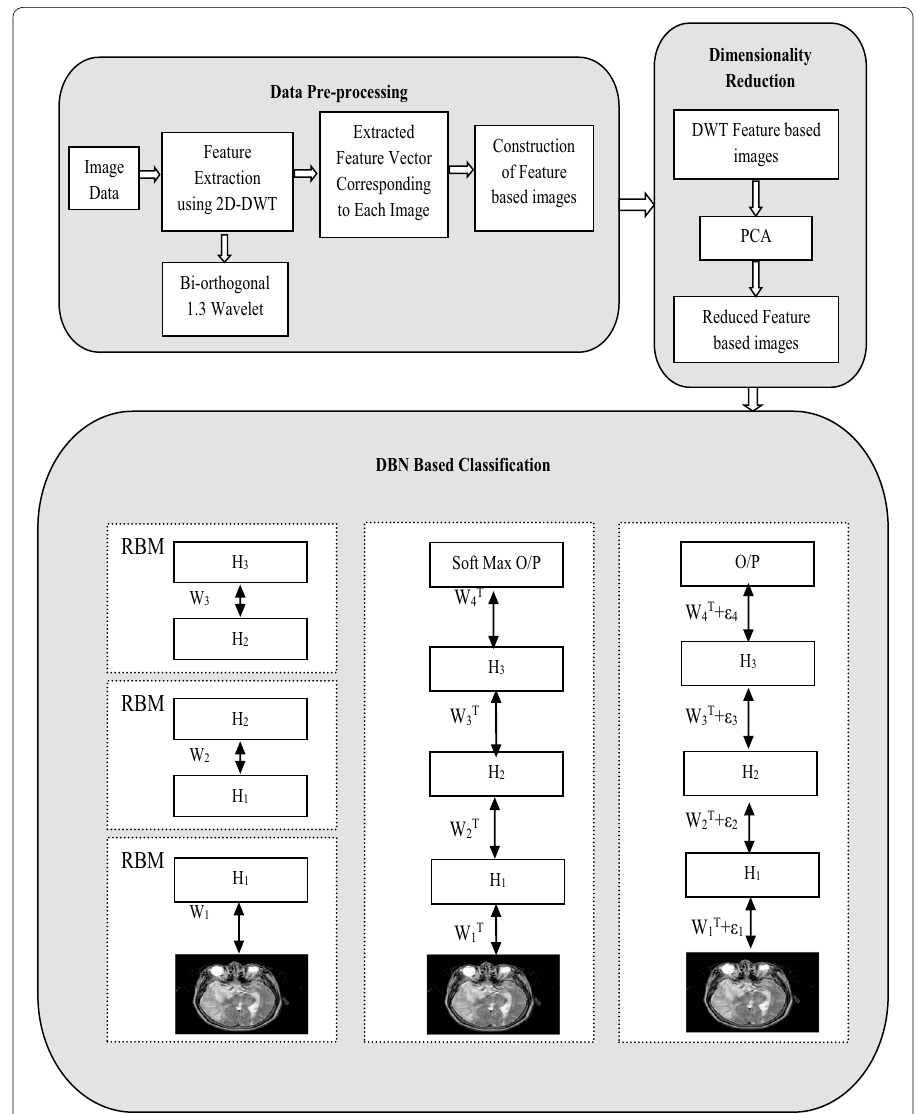
Fig. 3 Proposed framework for image classification using deep belief